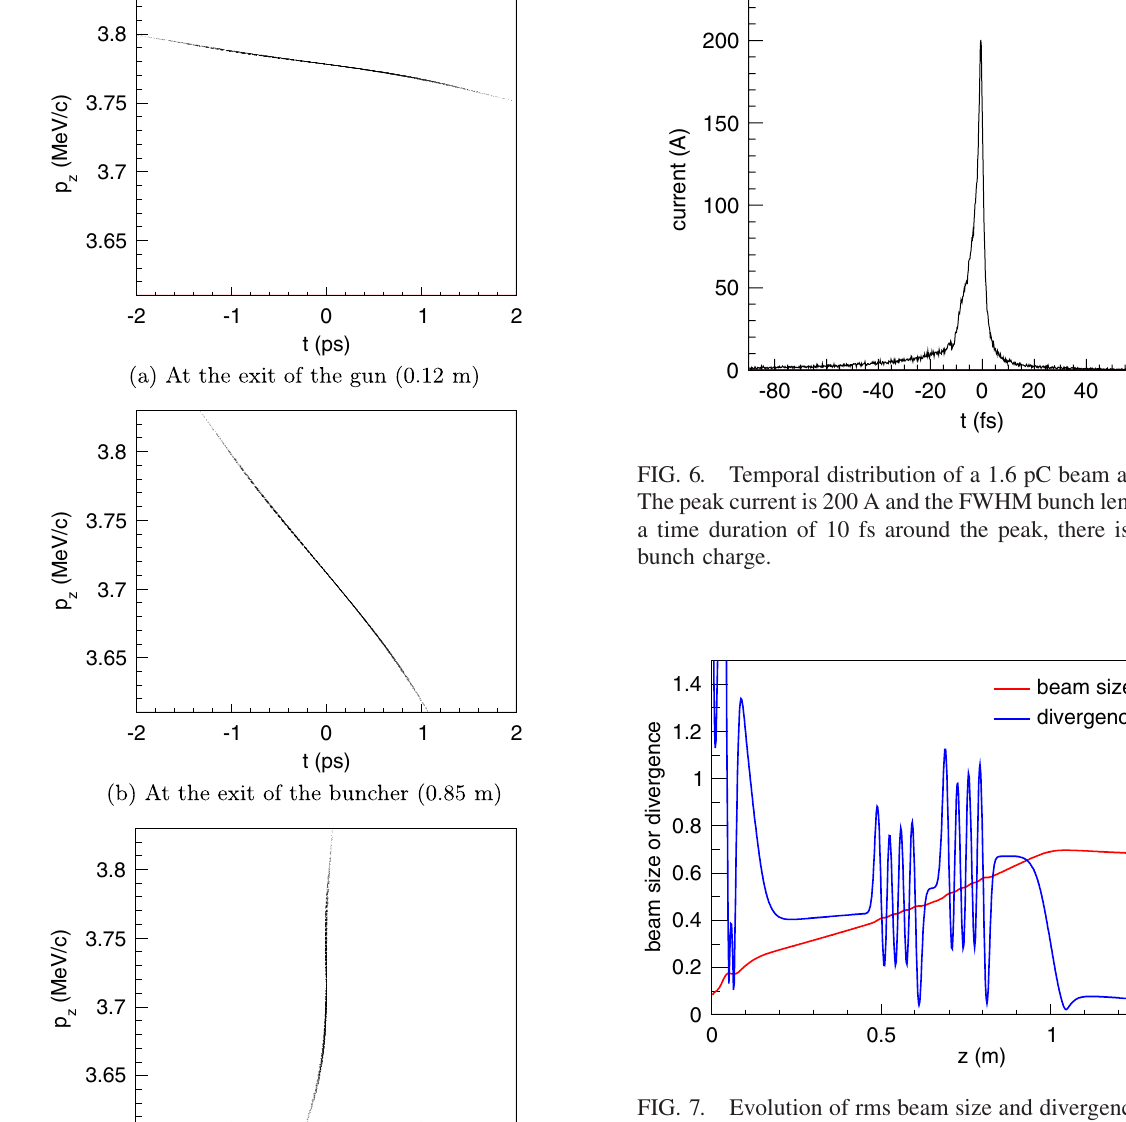
FIG. 7. Evolution of rms beam size and divergence. The beam size and divergence are controlled with the focusing solenoids around the gun and after the buncher. At the sample, the rms beam size is 0.67 mm and the rms divergence is 26 (cid:4) rad .